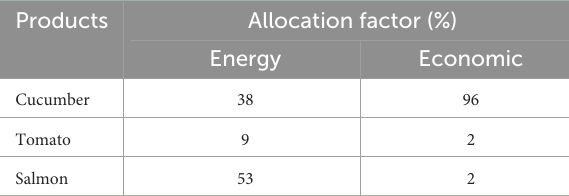
TABLE 1 Allocation factors based on the two allocation